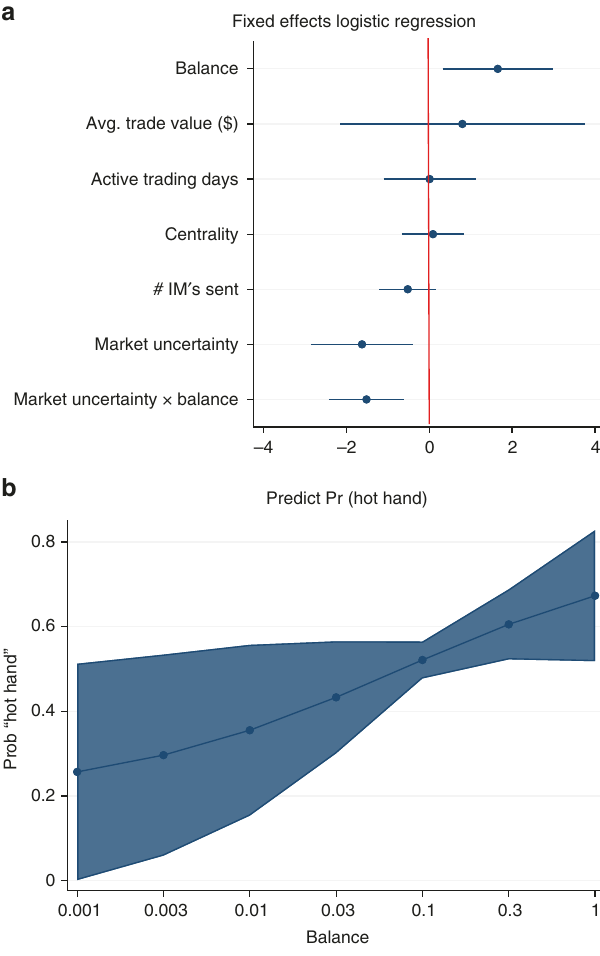
Fig. 6 Positive classical structural balance and having the “ Hot Hand ” . a Shows coef fi cient estimates from an individual trader and period fi xed effects for Logit regression. b Margins plot of the predicted relationship between the level of structural balance and having the hot hand based on the non-parametric regression. Values are means and 95% CI. Balance presents a superlinear effect. Positive relationship represents 75% of data. Traders trade best (i.e., have the hot hand) when their balance is relative high. The increase from medium to high balance has relatively high association of pro fi ts of nearly 30%. x -axis is reported as e log ( balance )